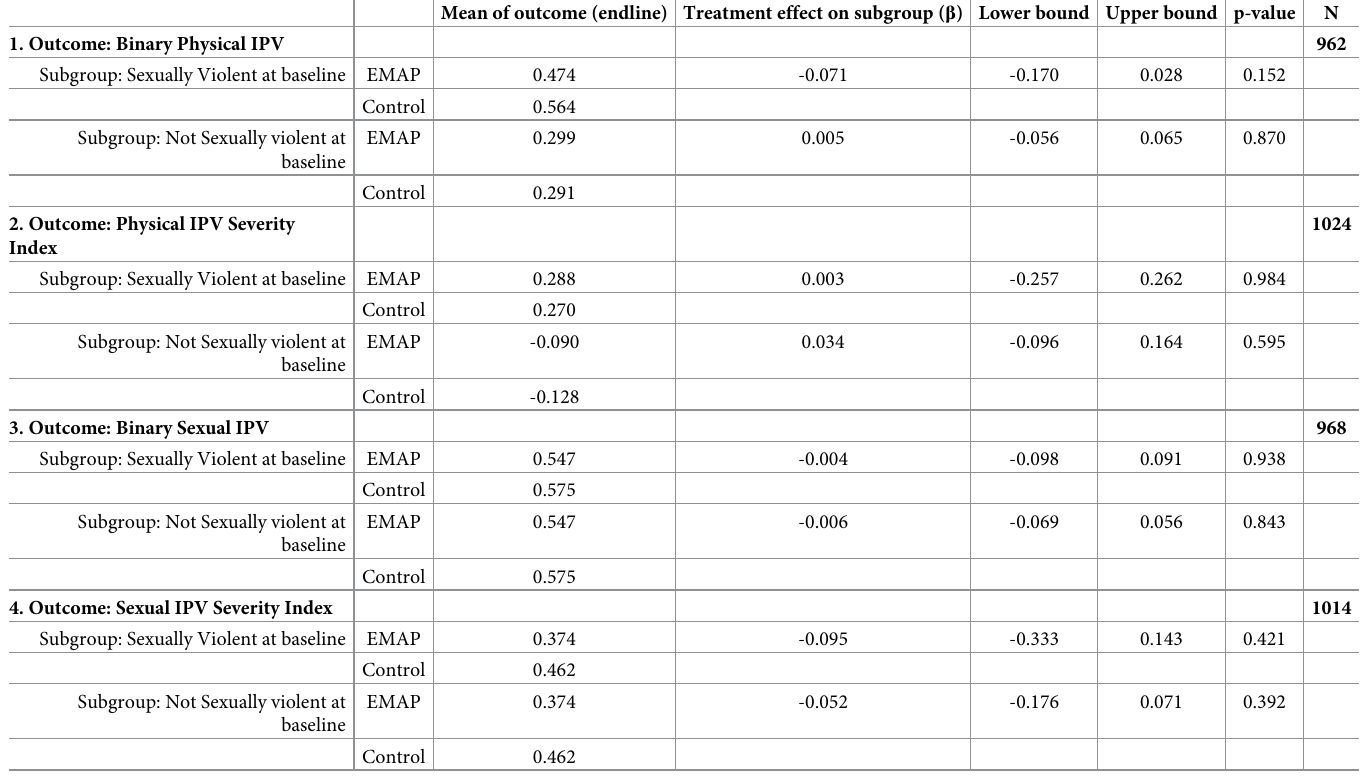
Table 5. Effects of EMAP on experience of IPV by subgroups of sexual IPV experience at